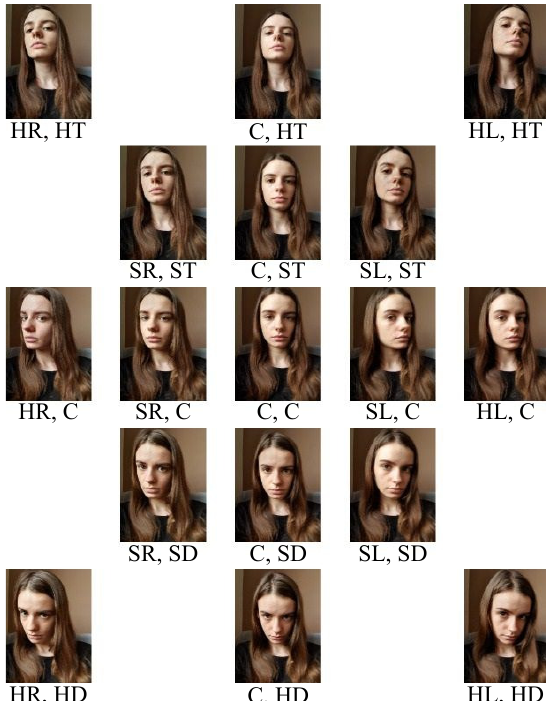
Figure 2. Example image set with the 17 assigned output classes. Table 1. Summary of the proposed output data classes. Horizontal Vertical Head Orient. Output Class Head